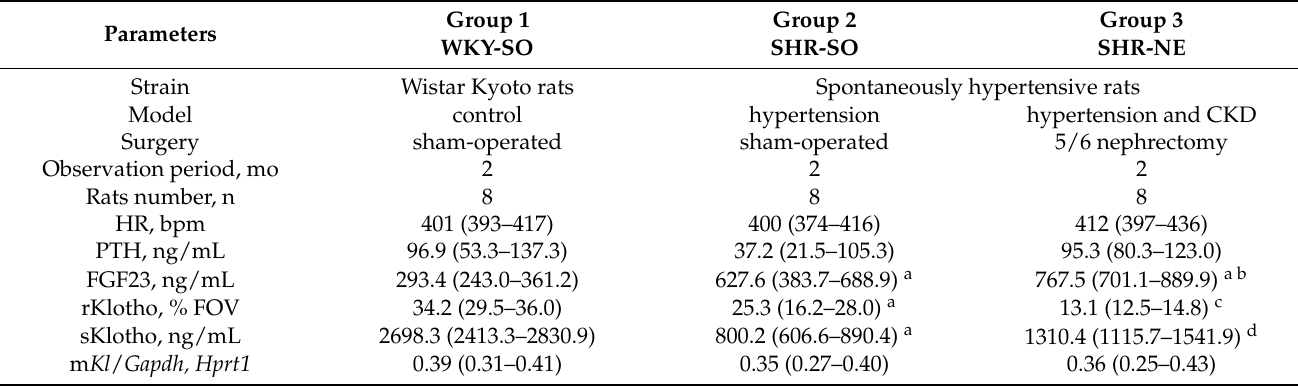
Figure 1. Kidney function and myocardial remodeling in the model of hypertension and chronic renal dysfunction (SHR-NE) and controls (SHR-SO, WKY-SO): ( a ) serum creatinine, ( b ) blood pressure, ( c ) myocardial mass index, ( d ) cardiomyocyte diameter (H&E and quantitative morphometry), ( e ) interstitial fibrosis (Masson’s staining and quantitative morphometry), and ( f ) Tgf β 1 mRNA relative expression; WKY—Wistar Kyoto rats; SHR—spontaneously hypertensive rats; SO—sham- operated; and NE—nephrectomy. Table 1. Animal models and the investigated